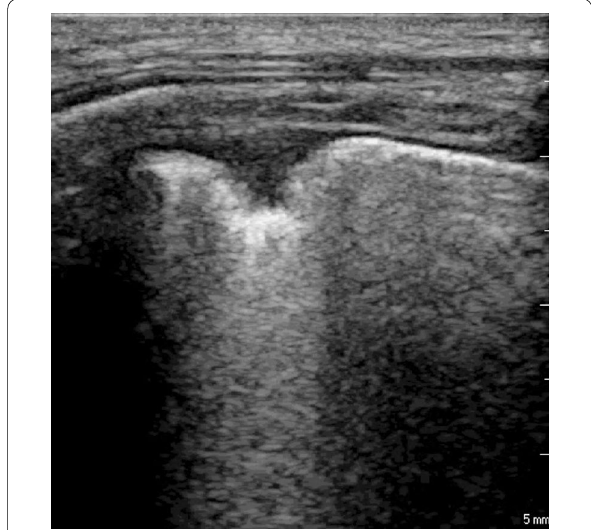
file 1: Table S1 reports LUS criteria for PE diagnosis and the reference test used in each study to formulate a final diagnosis of